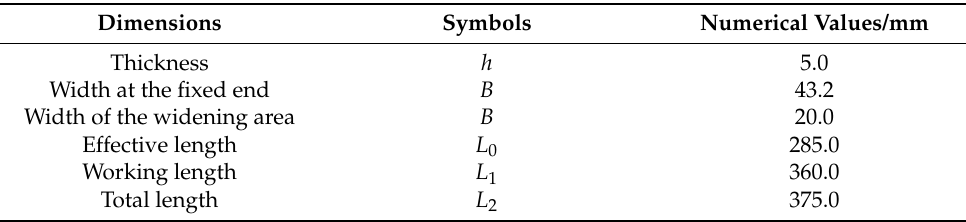
Table 1. Physical dimensions of the equal strength beam.